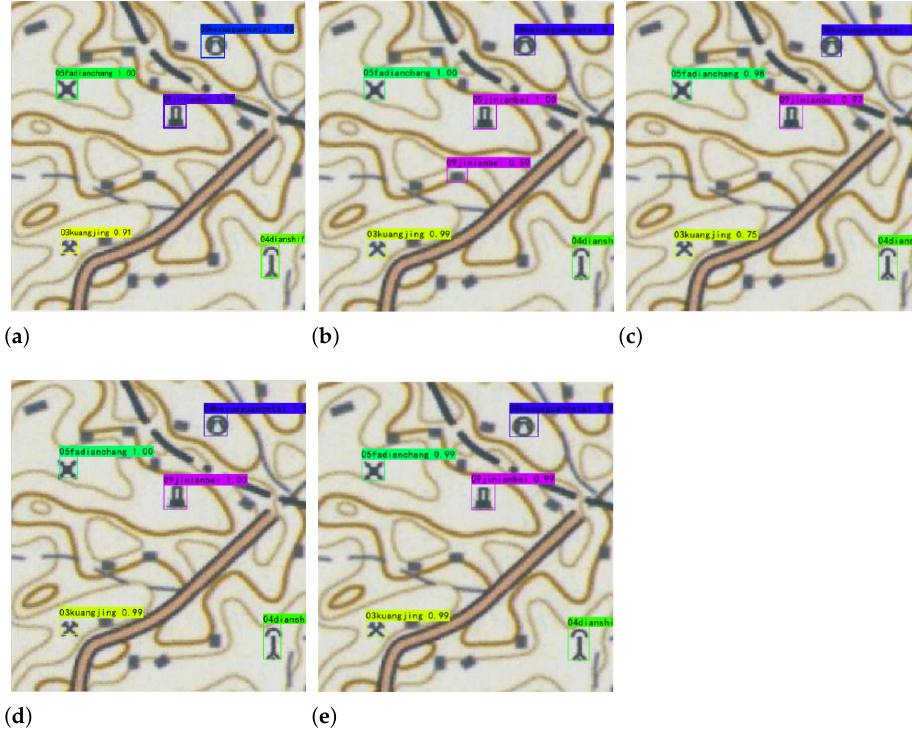
Figure 15. Results obtained by different models for Map C: ( a ) faster R-CNN, ( b )